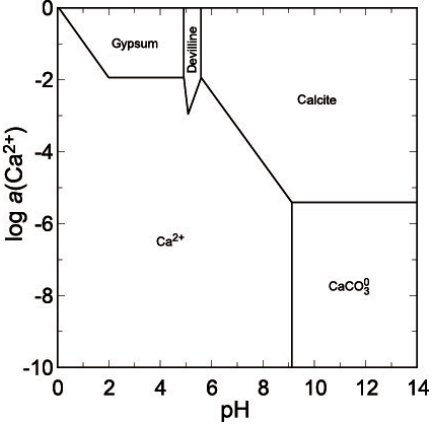
Figure 10. p ε -pH diagram of the system CaO − CuO − SO 3 − CO 2 − H 2 O for T = 298 . 15K, log a( Cu ( II )) = −